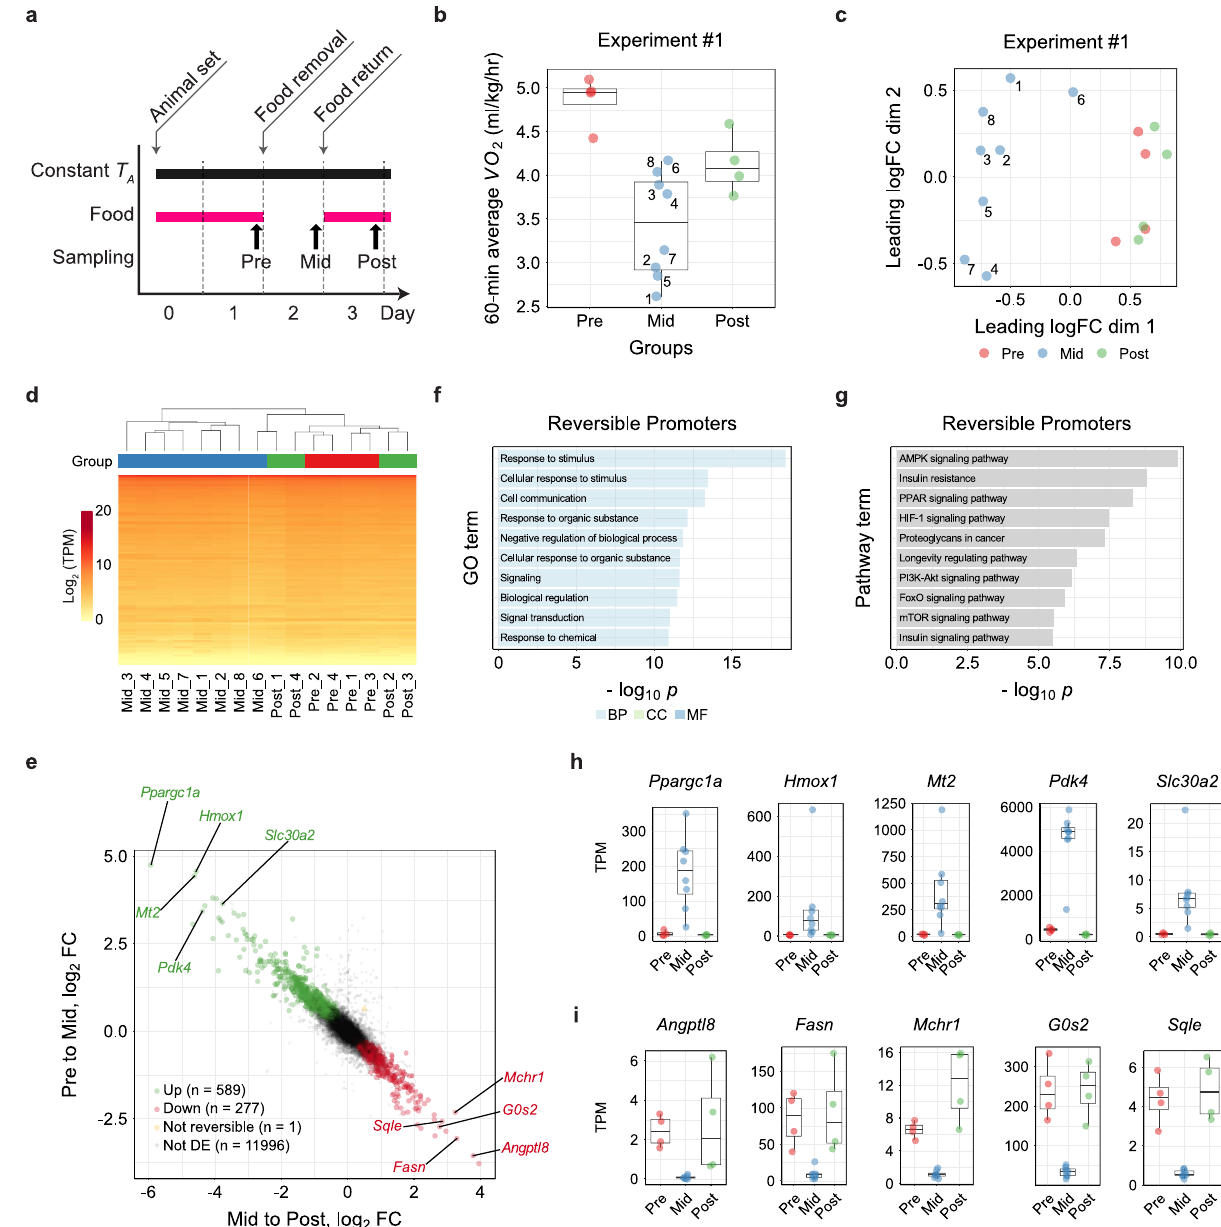
Fig. 1 Fasting-induced Torpor Shows a Reversible Transcriptome Signature. a Protocol for sampling muscles from Pre, Mid, and Post torpor animals to test the reversibility of the transcriptional pro fi le of muscles during torpor. b Boxplots for the VO 2 of animals at sampling in the reversibility experiment #1. Each dot represents one sample from one animal. During torpor (Mid group), the median VO 2 was lower than during Pre or Post torpor. The band inside the box, the bottom of the box, and the top of the box represent the median, the fi rst quartile (Q 1 ), and the third quartile (Q 3 ), respectively. The interquartile range (IQR) is de fi ned as the difference between Q 1 and Q 3 . The end of the lower whisker is the lowest value still within 1.5 IQR of Q 1 , and the end of the upper whisker is the highest value still within 1.5 IQR of Q 3 . Every other boxplot in this manuscript follows the same annotation rules. The numbers in the Mid torpor group are identi fi cation numbers of the animals. c MDS plot of the TSS-based distance in reversibility experiment #1. Each dot represents one sample from one animal. The Mid group clustered differently from the Pre and Post groups in the 1st dimension. The two internal groups seen in the Mid group in d were not evident in this plot, indicating the transient metabolic change during torpor was not correlated with transcription. d Hierarchical clustering heatmap based on the TPM of TSS detected in the reversibility experiment #1. The group colors are denoted in ( c ). e Distribution of CAGE clusters according to the fold-change (FC) in the TPM of Pre to Mid and Mid to Post torpor. The top fi ve up- and down-regulated reversible promoters that had annotated downstream genes are shown. f Top ten enriched GO terms in the reversible promoters. g Top ten enriched KEGG pathways in the reversible promoters. h , i Top fi ve up- and down-regulated reversible promoters ordered according to the magnitude of the TPM change. Promoters that had annotated downstream genes are shown.